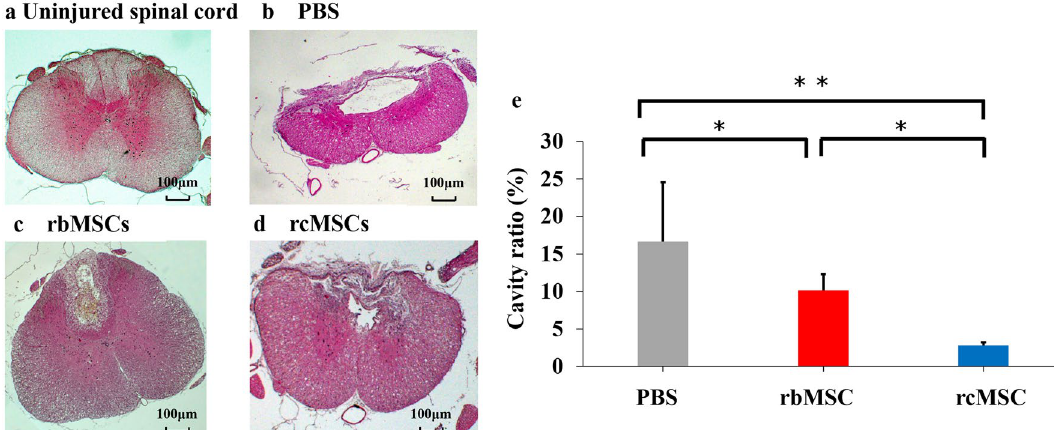
Figure 4. Cavity formation after spinal cord injury (SCI). Staining of the cavity formed after SCI (with hematoxylin and eosin). ( a ) Uninjured spinal cord, ( b ) PBS group, ( c ) rbMSC group, and ( d ) rcMSC group. The graph in ( e ) shows the difference in the volume of cavities at 28 days after SCI between the three groups. Data are presented as the mean ± SD. The cavity ratio in the rcMSC group was significantly lower than that in the three groups (* P < 0.05 and ** P < 0.01, respectively, n = PBS: 6, rbMSC: 6, rcMSC: 5).